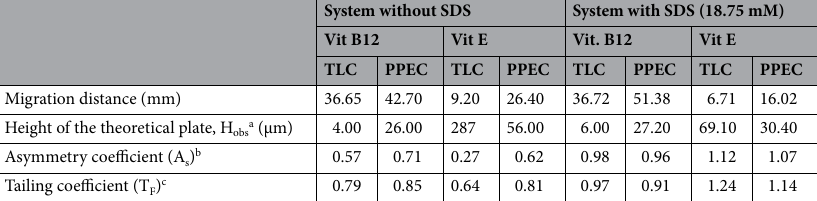
Table 2. A comparison of the PPEC and TLC experimental results. Here, the mobile phase consisted of 50% acetonitrile, 18.75 mM SDS and a buffer of pH 6.99 ((acetic acid, phosphoric acid, and boric acid (2.74 mM each) and sodium hydroxide (8.60 mM)). PPEC polarisation voltage applied was 1200 V, experiment time was 6 min. TLC eluent migration distance was 45 mm, experiment time was 11 min 30 s. Test solutes: Vit. B 12 and Vit. E Both peak tailing and asymmetry factor formulas were taken from 46 . a The height of the